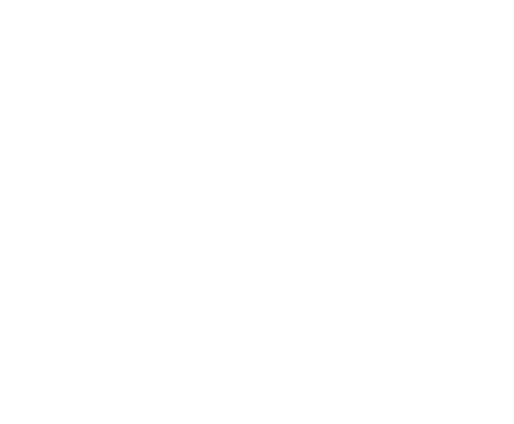
Table 1. Simulation parameters and their